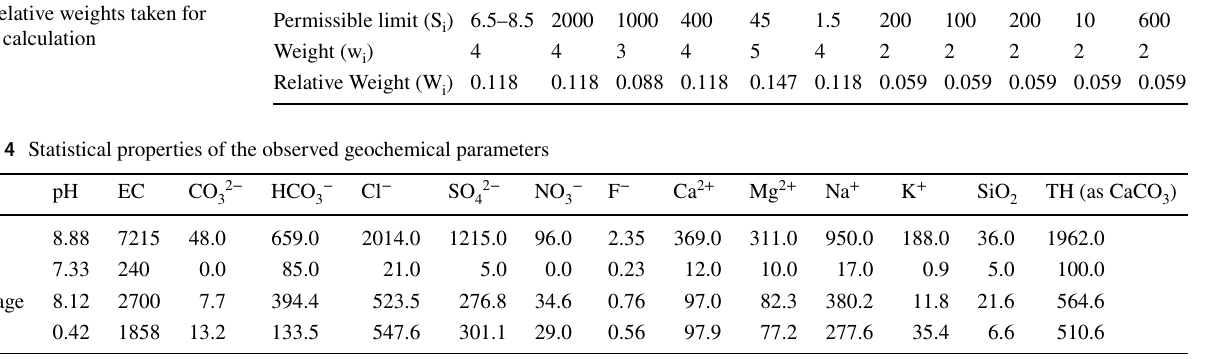
Table 2 The parameters and their permissible limits, weights and relative weights taken for WQI calculation